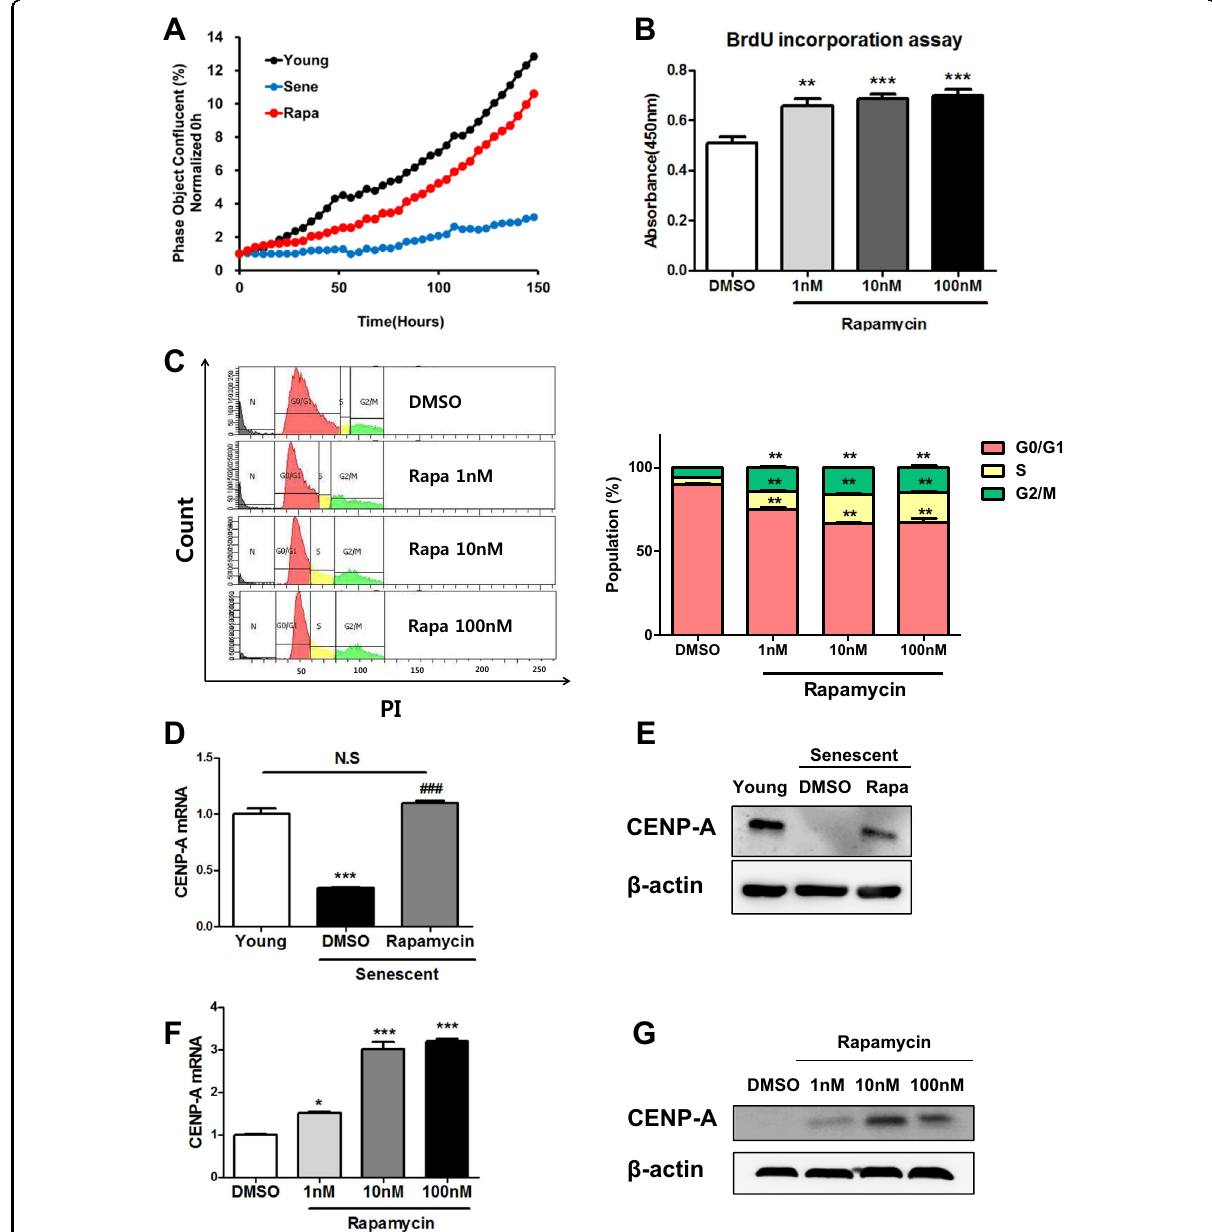
Fig. 2 Rapamycin improved senescent hCPC proliferation. a Real-time cell proliferation analysis (young passage number 8; senescent passage number 18; rapamycin passage number 18). b Cell proliferation assay was detected by BrdU labeling after prolonged treatment with different concentrations of rapamycin (** p ≤ 0.01, *** p ≤ 0.001, n = 6). c Cell cycle analysis (** p ≤ 0.01, n = 0.03). d , g The expression of CENP-A from senescent hCPCs after prolonged rapamycin treatment (* p ≤ 0.05, *** p ≤ 0.001, n = 3). Error bars indicate